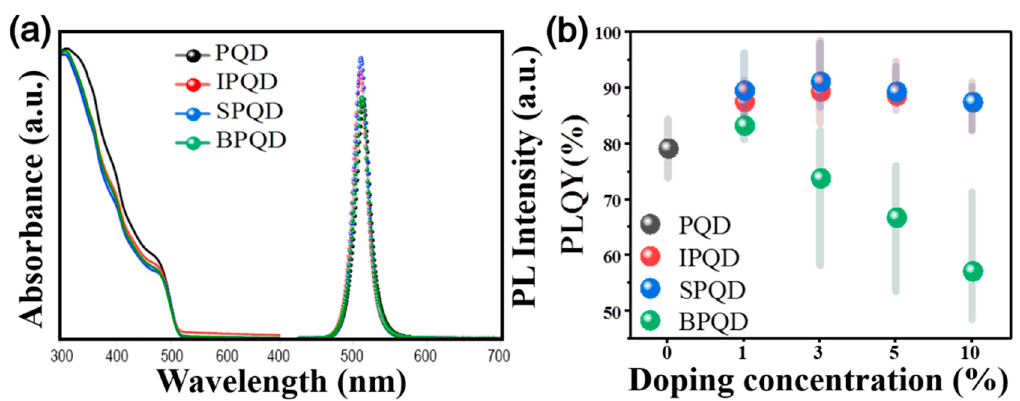
Figure 2. Characterization of pure and trivalent ion substituted CsPbBr 3 perovskite QDs. ( a ) Absorbance and photoluminescence (PL) spectra, and ( b ) photoluminescence quantum yield (PLQY) value averaged from 5 measurements. Table 1. Photoluminescence parameters of CsPbBr 3 perovskite quantum dots doped with different metal ions. Each result has an average of five measurements. Doping